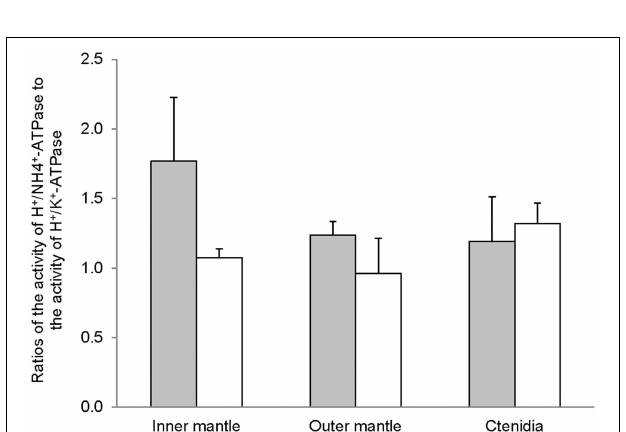
FIGURE 5 | The effectiveness of NH + 4 substituting for K + to activate H + /K + -ATPase (HKA), expressed as the activity ratio of H + /NH + 4 -activated HKA to H + /K + -activated-HKA, from the inner mantle, the outer mantle, and ctenidia of Tridacna squamosa exposed to 12h of darkness (control; closed bar) or 12h of light (open bar). Values represent means + S.E.M. ( N = 4 ).